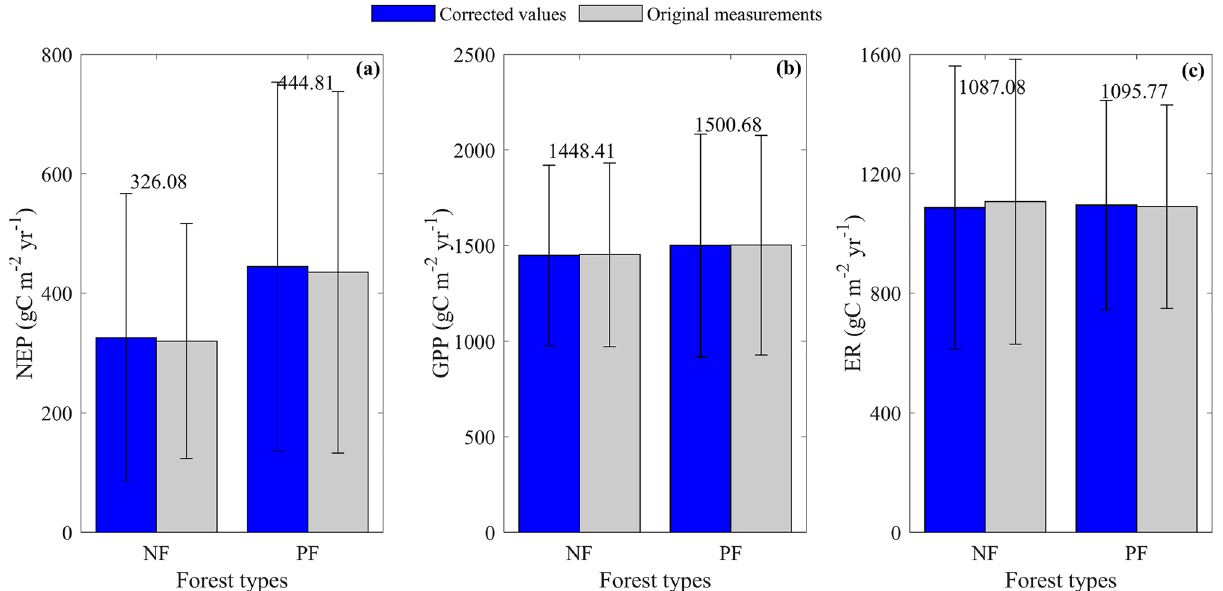
Figure 2. The differences in carbon flux values between naturally regenerating forests (NF) and planted forests (PF) in China. The carbon fluxes include net ecosystem productivity (NEP, a ), gross primary productivity (GPP, b ), and ecosystem respiration (ER, c ). The differences are tested for each flux with one-way analysis of variance (ANOVA) and analysis of covariance (ANCOVA) by fixing other variables as a covariant. All results show no significant difference between NF and PF (p > 0.05). The corrected values and original measurements are same to those in Fig.